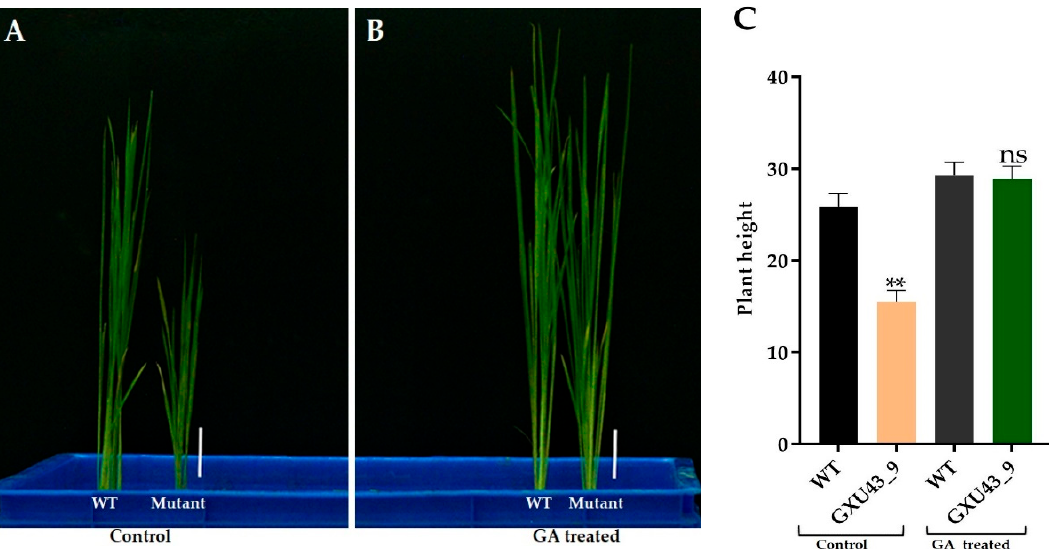
Figure 3. The seedling phenotype of the homozygous mutant GXU43_9 and WT. ( A ) Seedlings phenotype without GA, ( B ) Seedlings treated with GA, and ( C ) PH (plant height)of GA3-treated and control ( n = 15), Bars = 3 cm. Data are mean ± SD. “**” and “ ns” represent a significant and non- significant difference respectively at p ≤ 0.01.